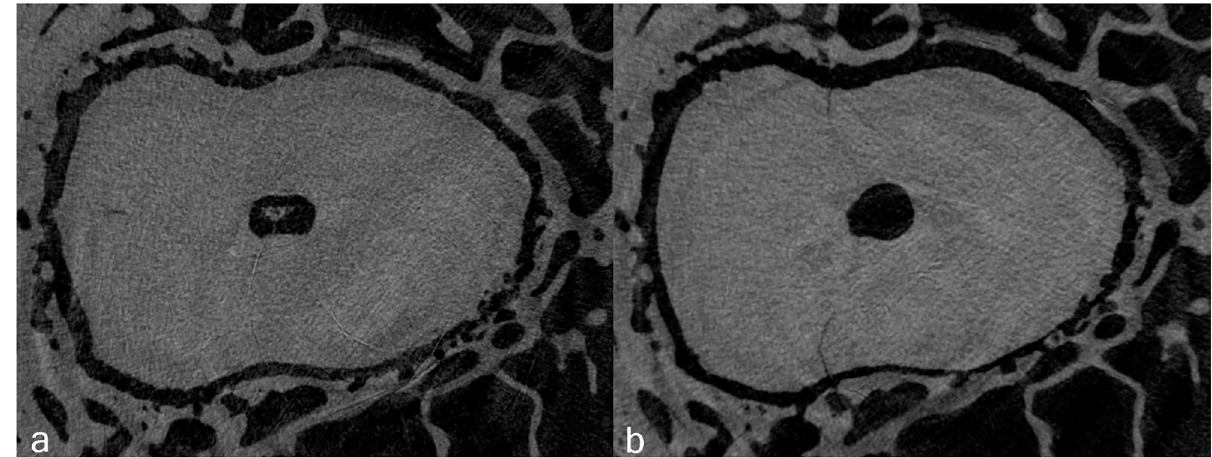
Fig 4. New microcrack after root canal preparation. Representative preoperative (a) and postoperative (b) cross-sectional slices with a new microcrack after root canal preparation.